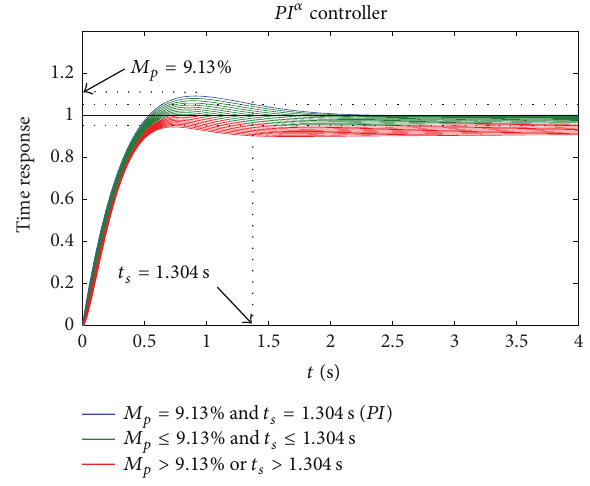
Figure 2: Unity feedback control